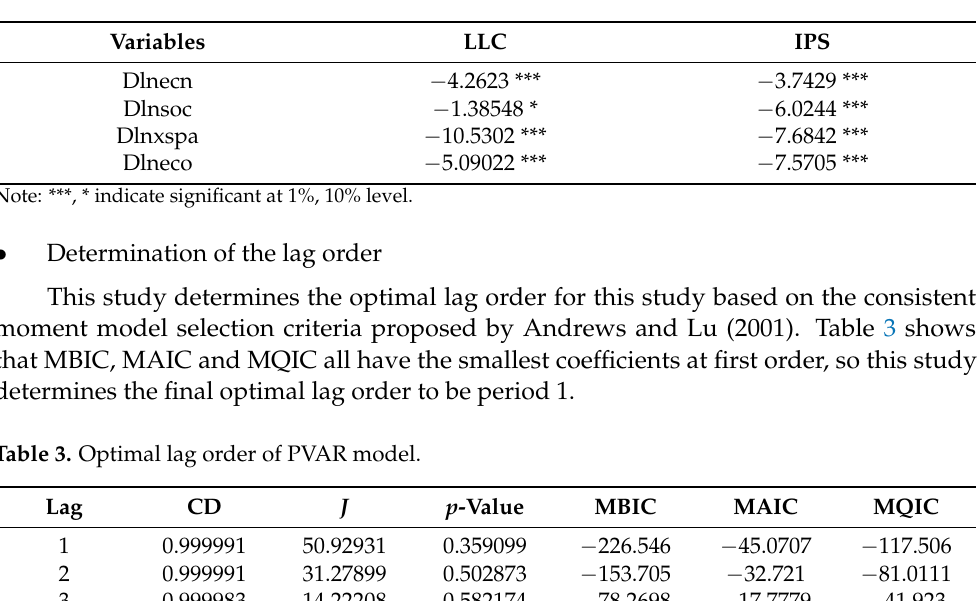
Table 2. Unit root test results.